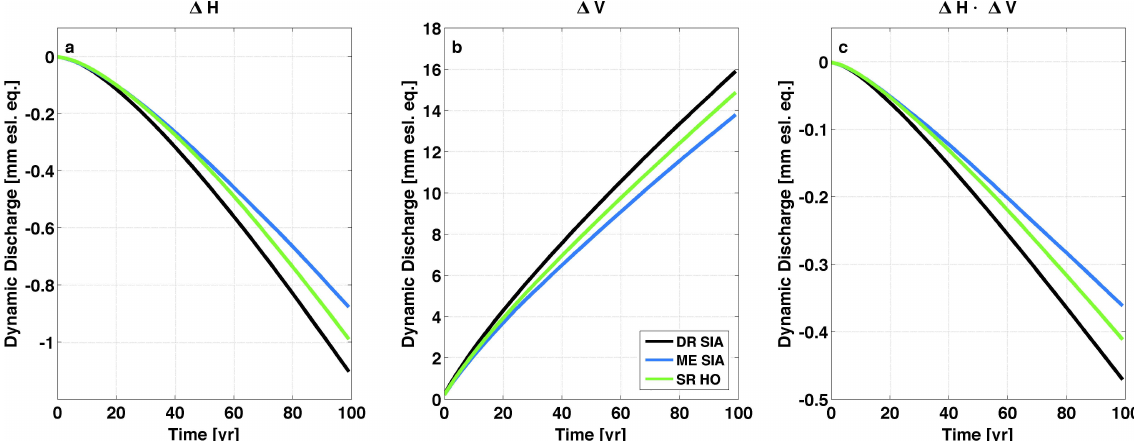
Fig. 7. Decomposition of changes in ice discharge for MarAsl2 into contributions from different evolution in (a) ice thickness alone, (b) ve- locity magnitudes alone and (c) their combination (cf. Eq. 1). Together with changes in surface mass balance all these curves add up to the total volume loss in Fig.